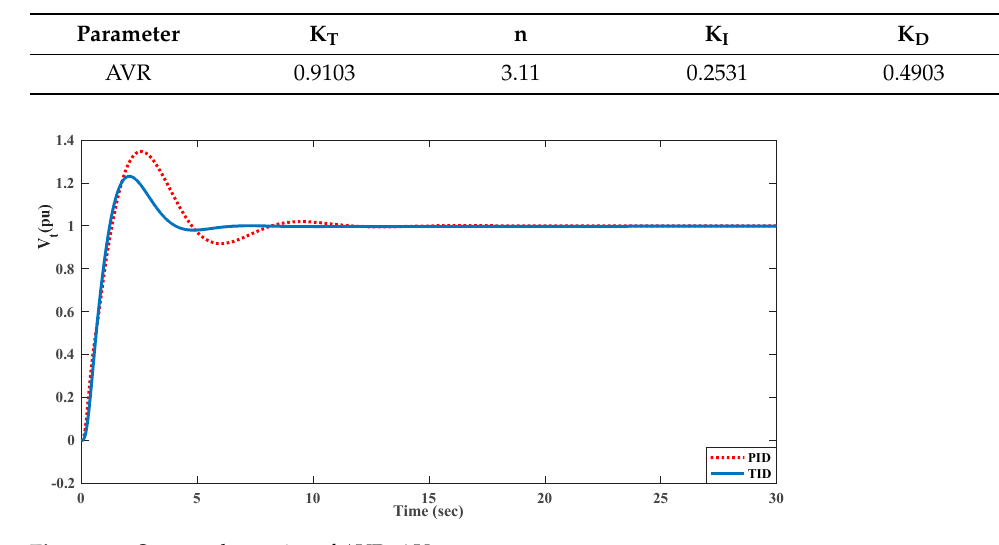
Table 13. Optimized TID controller parameters for AVR.